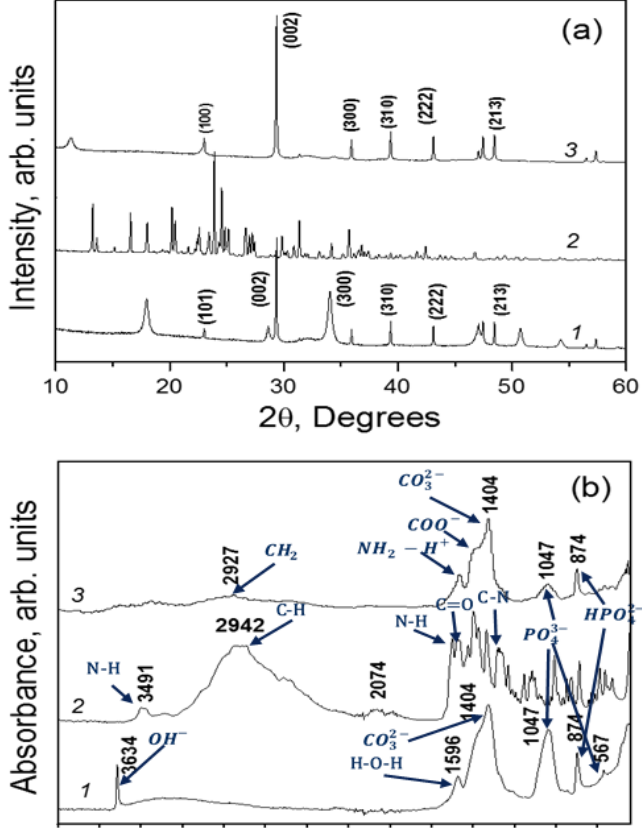
Figure 1. ( a ) Powder X-ray diffraction patterns, and ( b ) FTIR spectra of (1) hydroxyapatite (HA), (2) L-lysine (Lys), and (3) Lys/HA hybrid material. (2) L-lysine (Lys), and (3) Lys/HA hybrid material.